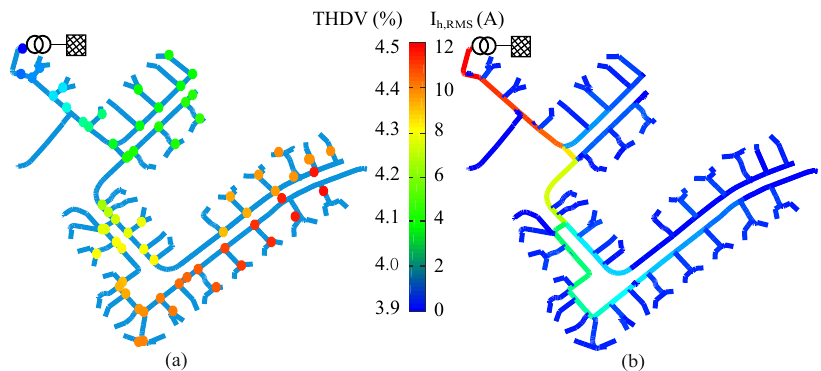
Figure 16. An example of harmonic distortion through the network for 2016: the 95 percentile value. ( a ) The THDV over the network; and ( b ) the root mean square ( RMS ) value of the total harmonic current.